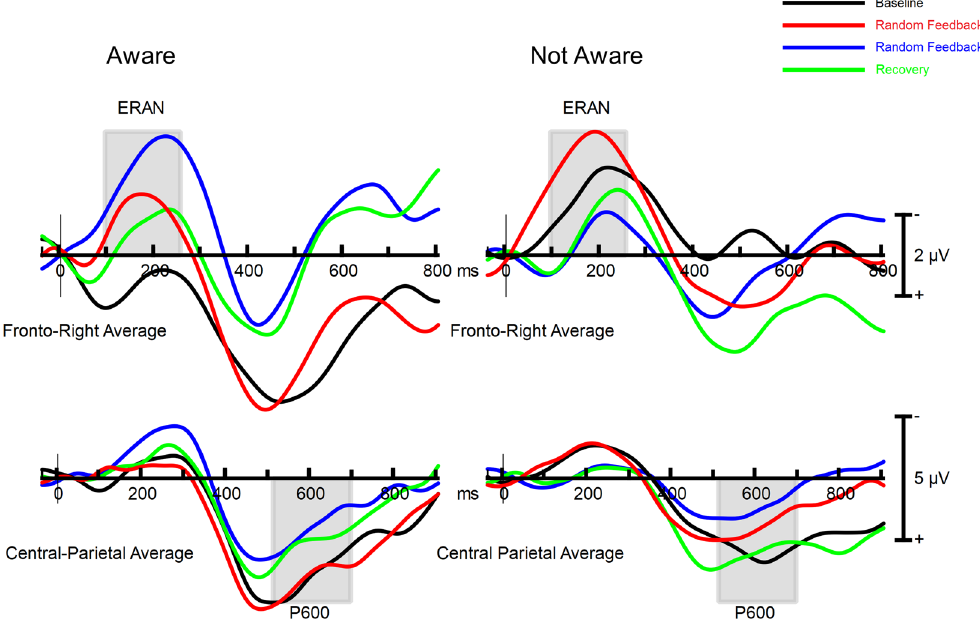
Figure 5. Aware ( n = 7) and non-aware ( n = 11) ERP difference waveforms (out-of-key minus in-key) for the ERAN at electrode F4 (top) and the P3 at electrode POz (bottom) in the experimental group. Grey lines highlight the ERAN, P300, and